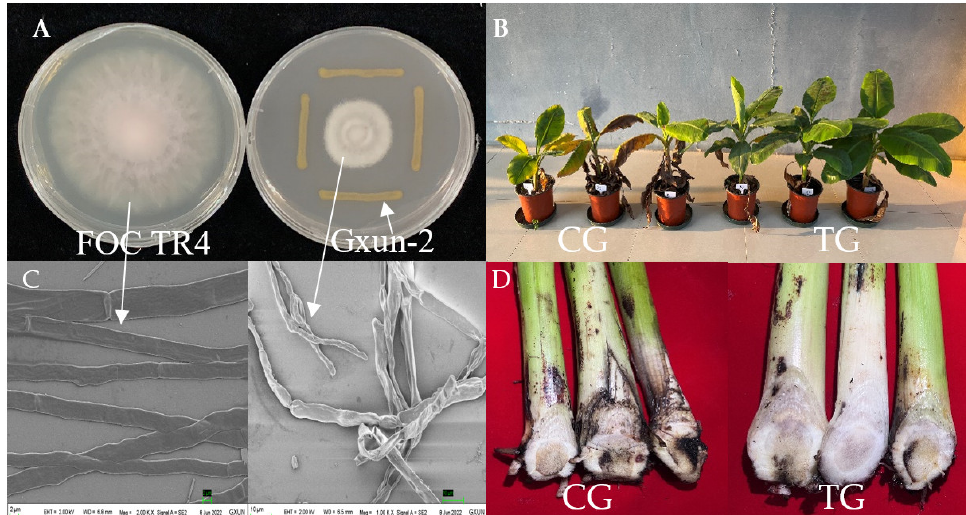
Figure 1. Antagonistic effects of Gxun-2 strains against Fusarium oxysporum f.sp. cubense (FOC TR4). ( A ) Gxun-2 inhibited the growth of FOC TR4; ( B ) Pot control effect of strain Gxun-2 on FOC TR4. ( C ) Hyphae morphology of FOC TR4 on PDA plate and dual-culture plate under the scanning elec- tron microscope. ( D ) Browning of banana seedling bulb profile. CG: control group; TG: treated